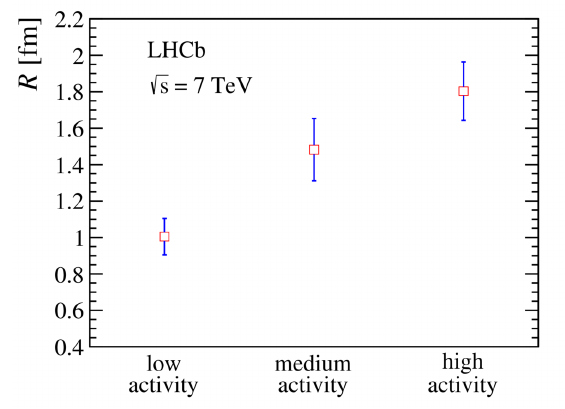
Figure 4. Correlation radius as a function of event-activity from pp data